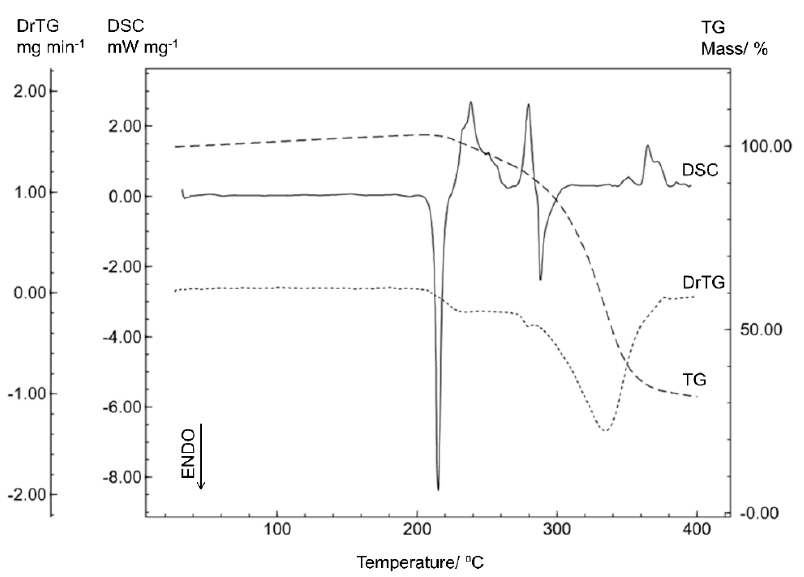
Figure 3. The DSC and TG/DTG curves for sitagliptin phosphate anhydrous (STGA) obtained with a synthetic air atmosphere (50 mL min − 1 ) and a heating rate of 10 °C min − 1 .